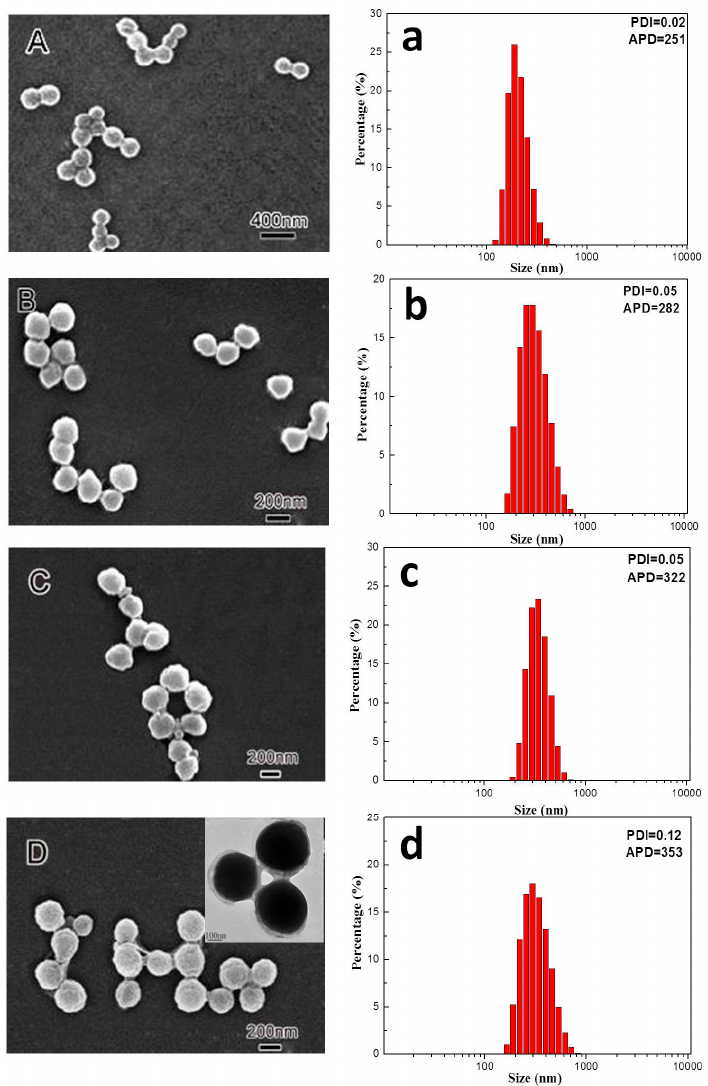
Figure 1. Scanning electron microscope (SEM) micrographs ( A – D ); and size distributions ( a – d ) of PVDF (Poly(vinylidene fluoride))@PMMA (Polymethylmethacrylate) series at the